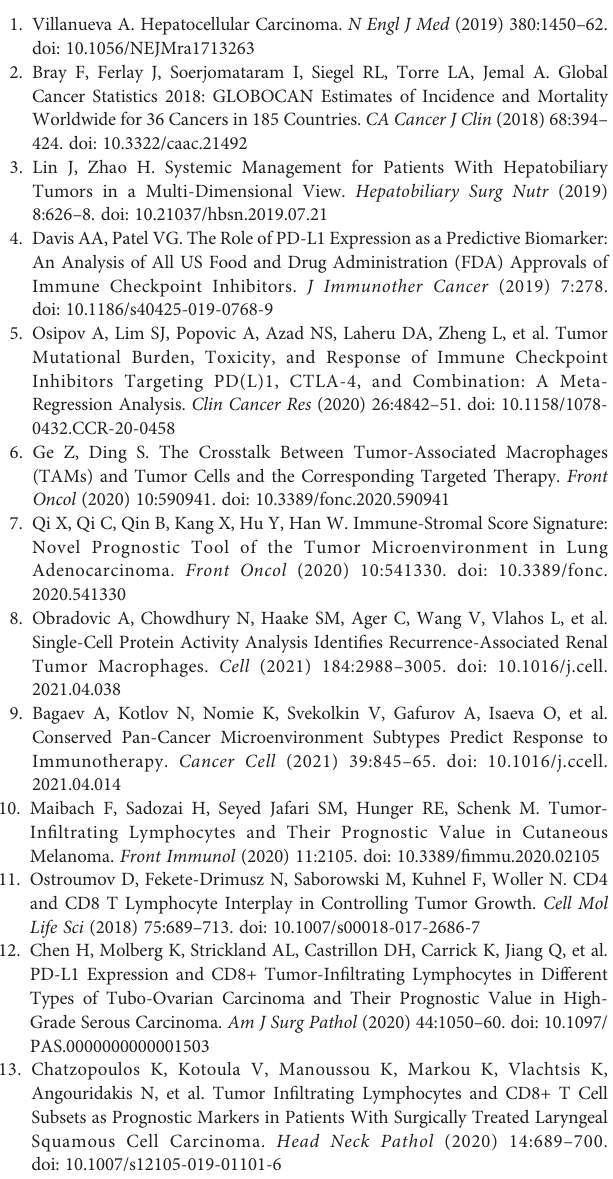
Supplementary Figure S5 | Comparison of ICI score between HCC samples with mutation and without mutation of the TOP 20 oncogenic drivers with the highest alteration frequency. Supplementary Figure S6 | Effect of expressions of the TOP 20 oncogenic drivers with the highest alteration frequency on prognosis. Supplementary Figure S7 | Comparison of the in fi ltration levels of immune cells between HCC samples with and without CTNNB1 mutation. Supplementary Figure S8 | Correlations between CTNNB1 expression and expression of killer immunoglobulin-like